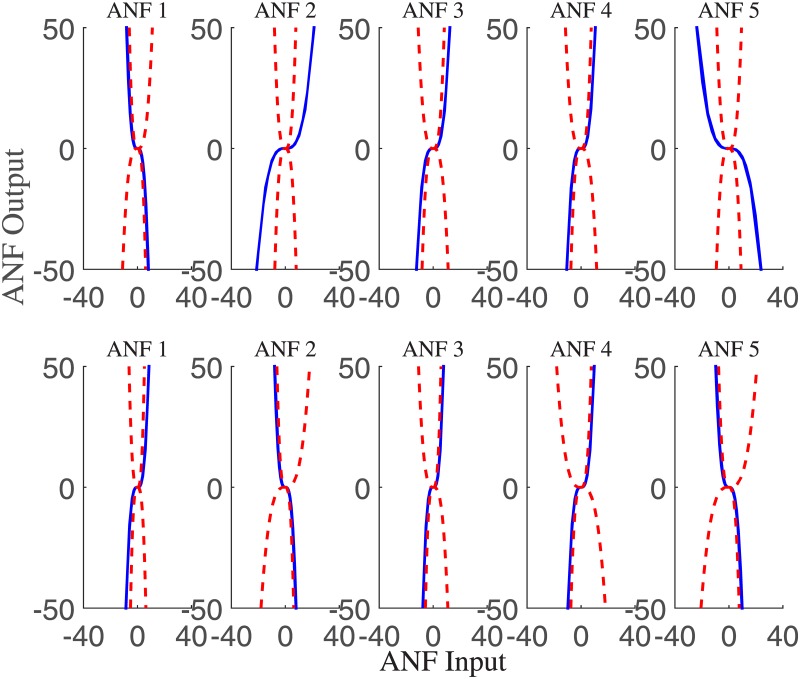
The ensemble averages of estimated cubic ANFs along with their standard deviation bounds for the T7–P7 (top panels) and Fp1–F3 (bottom panels) for the ictal states of the training data set.The solid lines represent means and dotted lines represent standard deviation bounds. Coefficients of cubic ANFs were utilized to determine the mean and standard deviation bounds. ANFs, associated nonlinear functions.